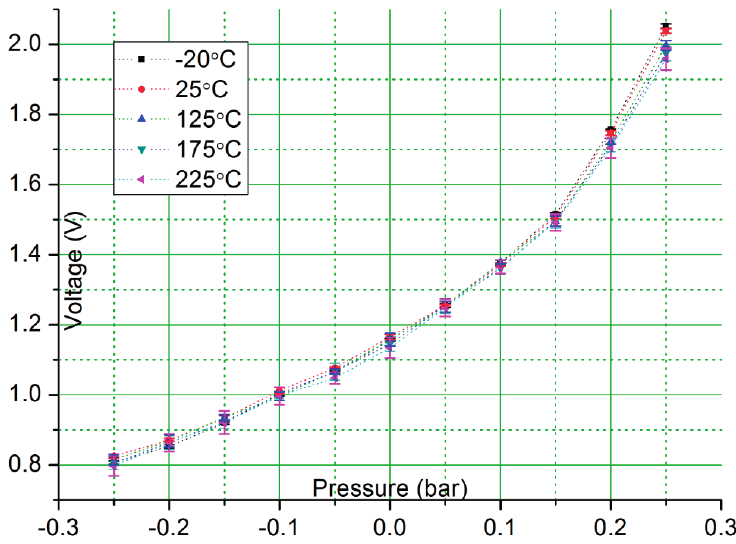
Figure 7. Measured output response of the CMOS interface circuit with a capacitive MEMS pressure